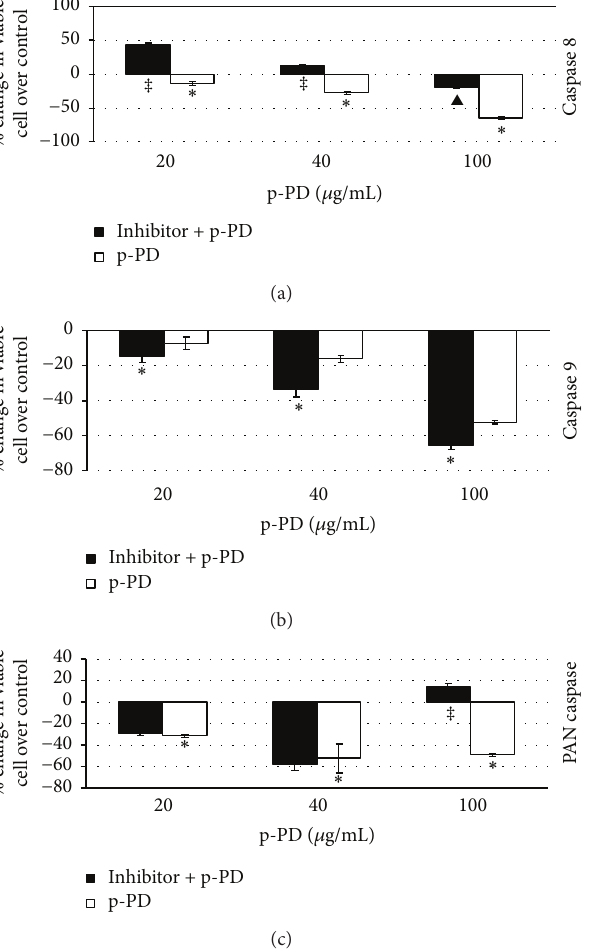
Figure 6: Caspase 8 inhibitor decreases the number of dead A375 cells. Cells were pretreated with the inhibitors of caspase 8 (a), caspase 9 (b), and PAN caspase (c) for two hours and subsequently treated with p-PD for 24 hours. Percent change in viable cells in sets with inhibitor pretreatment was computed as described in the Materials and Methods. The net protective effect ( ‡ ) is either the | value of white bar + value of black bar | or the decrease in dead cell number as denoted by 󳵳 . By conventional criteria, this difference is considered to be extremely statistically significant. ∗ indicates the two-tailed 𝑝 value ≤ 0.005. Each set was performed in